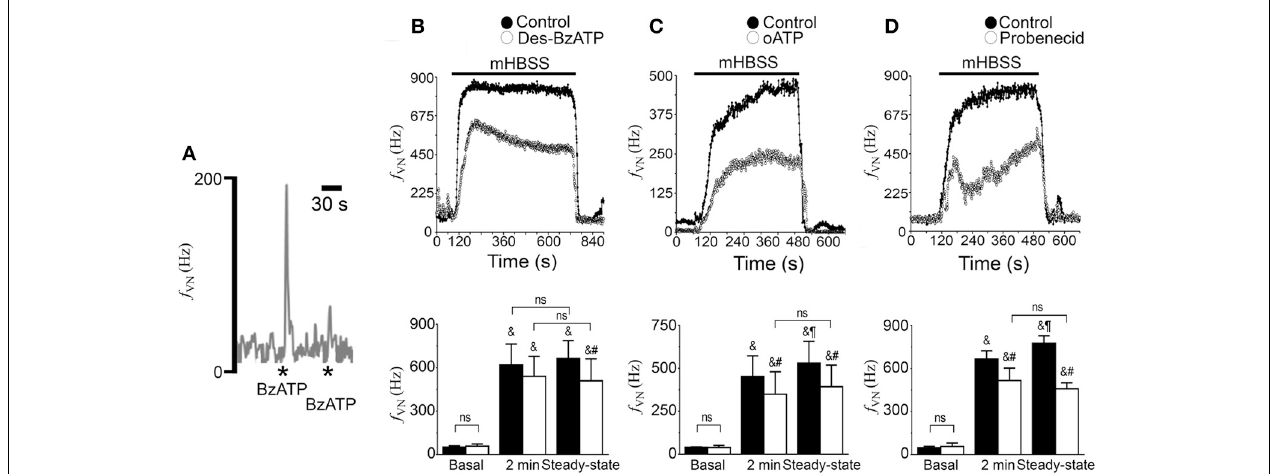
FIGURE 7 | Neuronal activation induced by mHBSS is sensitive to P2X 7 receptor-Panx1 channel blockers and neurotransmitters. Representative recordings of rat NPJcs superfused with mHBSS in the absence (control) or presence of P2X7/Panx blockers. (A) 200 μ M of BzATP induced a rapid and transient increase in f VN ; however, a second application of BzATP induced only a small response (desensitization). Asterisks show the moment of application of a BzATP bolus to the bath solution. Neuronal frequency of discharge recorded from NPJcs superfused with mHBSS before (Control, filled circles) andafter(emptycircles)P2X 7 desensitization( B ; n = 4).Neuronalfrequencyof discharge recorded from NPJcs superfused with mHBSS alone (Control, filled